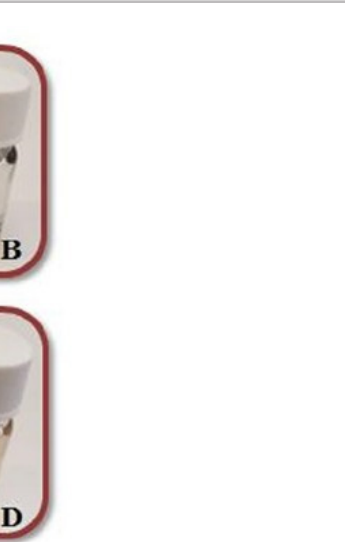
FIGURE 1 - A. Fe particles before magnetic separation, D. Gold coated Fe